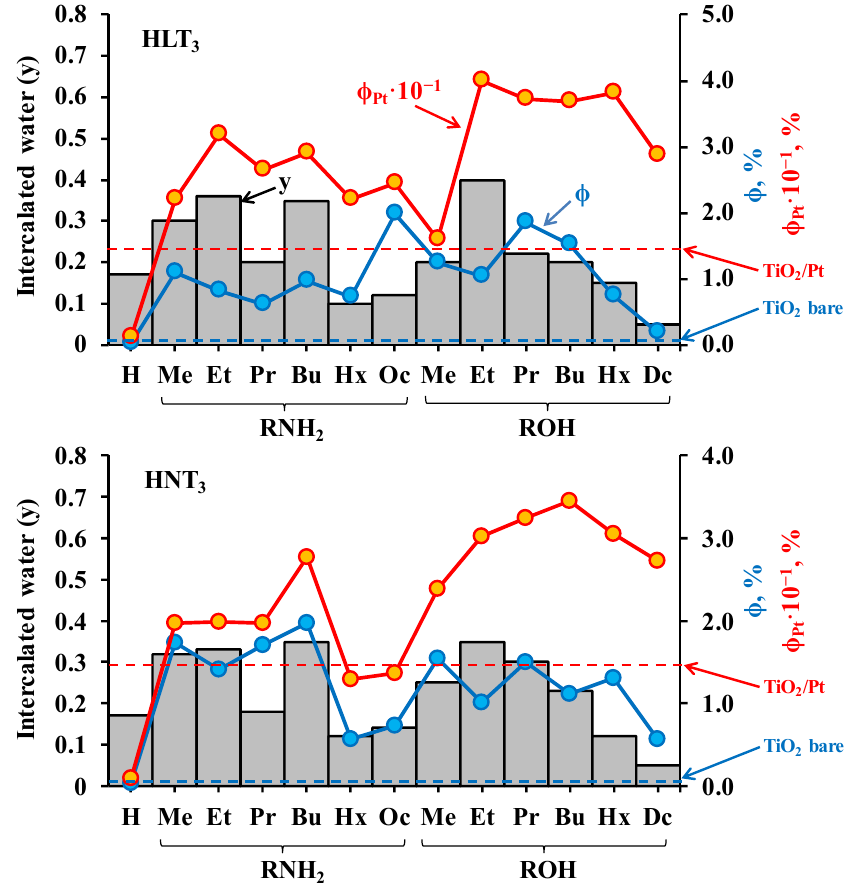
Figure 7. Correlation between photocatalytic activity and hydration degree of the interlayer space. Horizontal dashed lines correspond to the activity of bare (blue) and platinized (red) TiO 2 P25 Degussa under the same conditions.